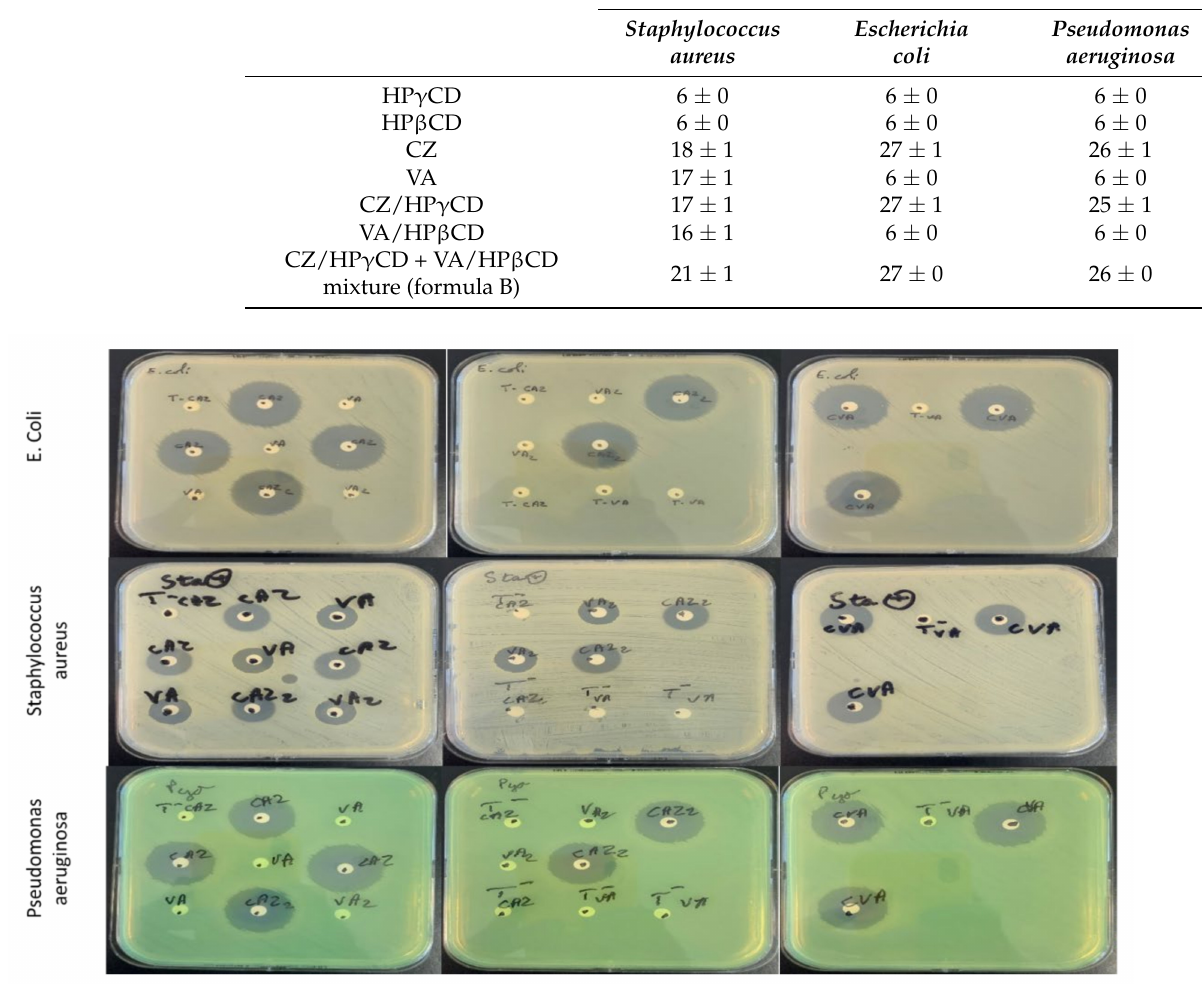
Figure 6. Culture of E. coli ATCC 25922, S. aureus ATCC29213 and P. aeruginosa ATCC27853 after 18 h of incubation at 35 ◦ C with different antibiotic solutions: T-VA: negative control pH 3 and T-CVZ: pH 4; CZ: Ceftazidime; VA: Vancomycin; CZA2: Ceftazidime + HP β CD at pH 4; VA2: Vancomycin + HP γ CD at pH 3; CVA: Formula